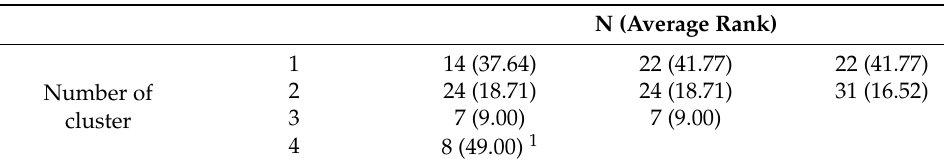
Table 9. Comparison of average ranks in clusters.